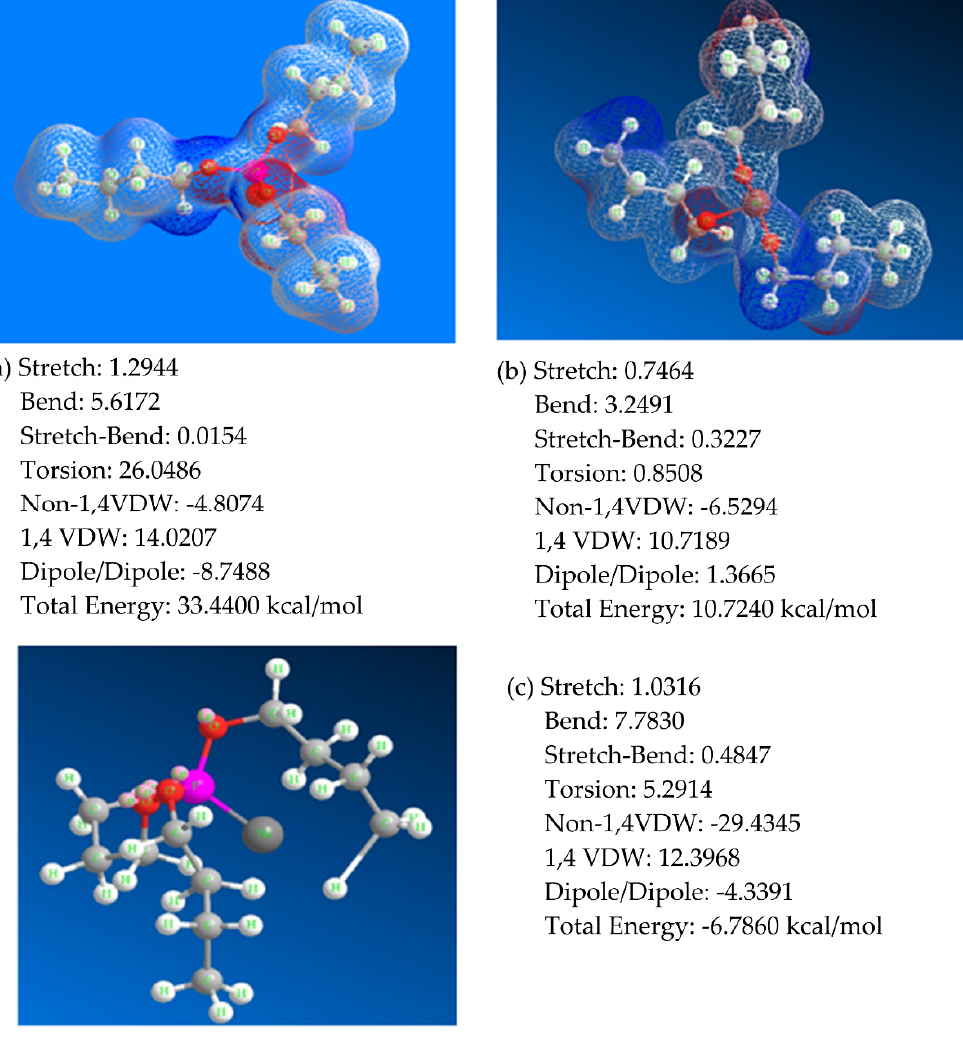
Figure 7. Modeling of possible metal extraction products with tributyl phosphate: ( a )–Tributyl phosphate molecule, ( b )–molecule of the proposed product of iron extraction with tributyl phosphate, ( c )–molecule of the proposed product of nickel extraction with tributyl phosphate.